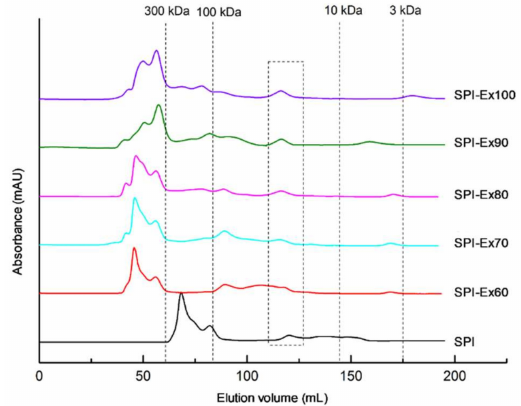
Figure 1. Molecular weight distributions of SPI extracted from full-fat soybean flakes powder with and without extrusion